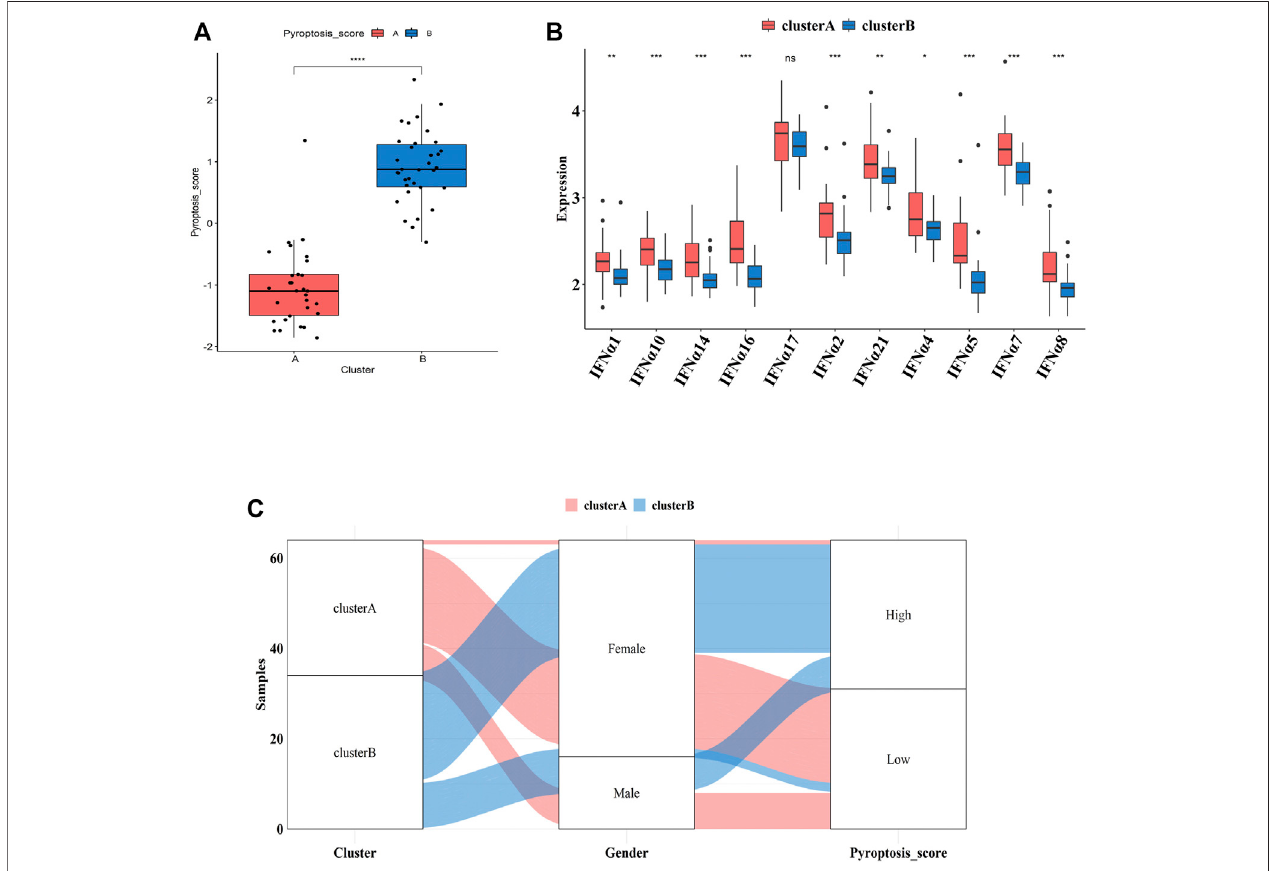
FIGURE 9 | Differences in PS-scores and IFN- α isoforms between two pyroptosis-related clusters (A) . Differences in PS-scores between cluster A and cluster B (B) .Therelationshipsbetweenclusters,gender,and “ PS-scores ” (C) .Differentialexpression levelsofIFN- α isoformsbetweenclusterAandclusterB.Adjusted p -values were showed as: ns, not signi fi cant; * p < 0.05; ** p < 0.01; *** p <